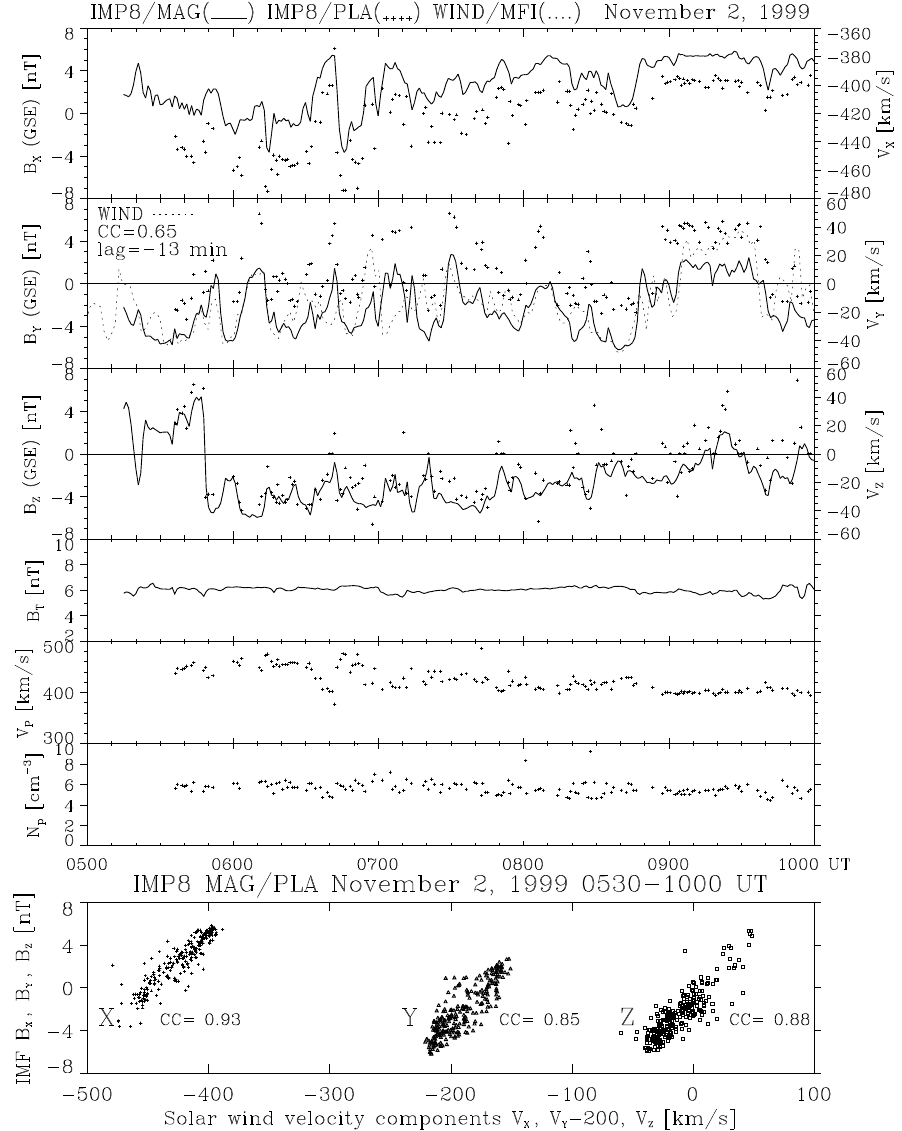
Fig. 5. The IMF (solid line) and solar wind plasma parameters (small crosses) indicate Alfv´enic fluctuations observed by IMP 8. The WIND IMF B y (dotted line) is shifted by 13min, which is the maximum cross-correlation lag between the IMP 8 and WIND time series. The bottom panel shows scatter plots and coefficients of correlation (CC) between the corresponding components of the IMF and ion velocity (for the B y versus V y scatter plot, the V y values are shifted by −